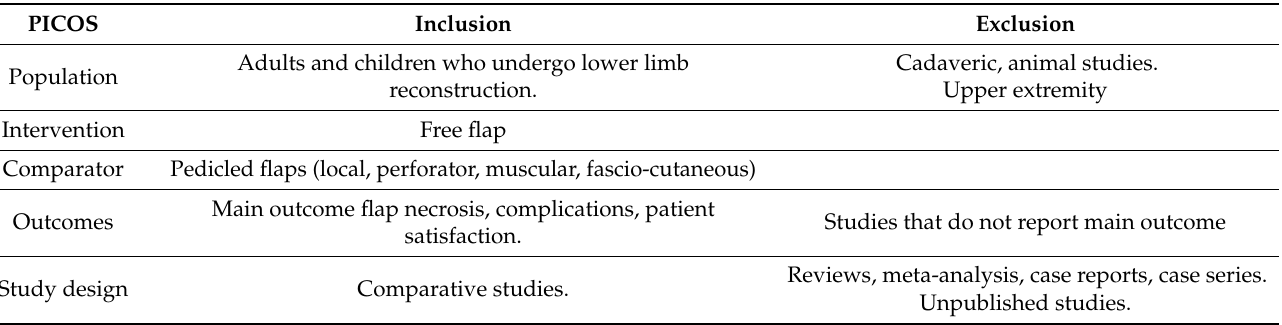
Table 2. Inclusion/exclusion